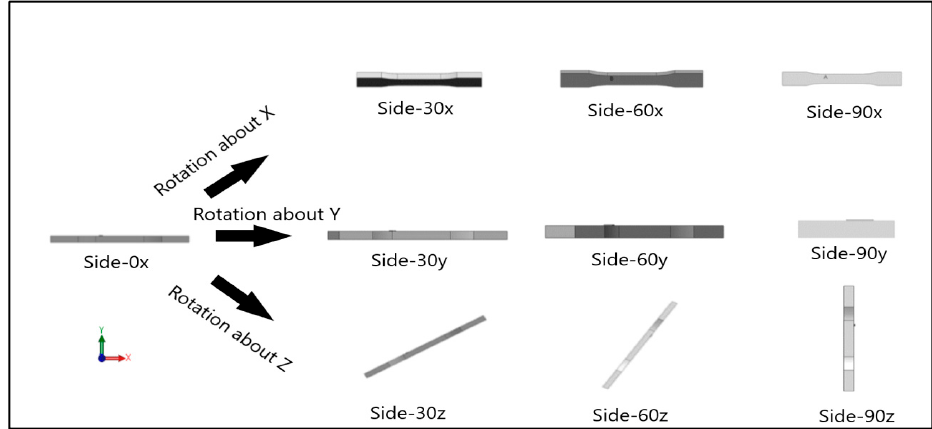
Figure 3. Front view of side-built samples, 0°, 30°, 60°, and 90° from left to right for each axis rotation (separate rows for x, y, and z-axis), respectively.